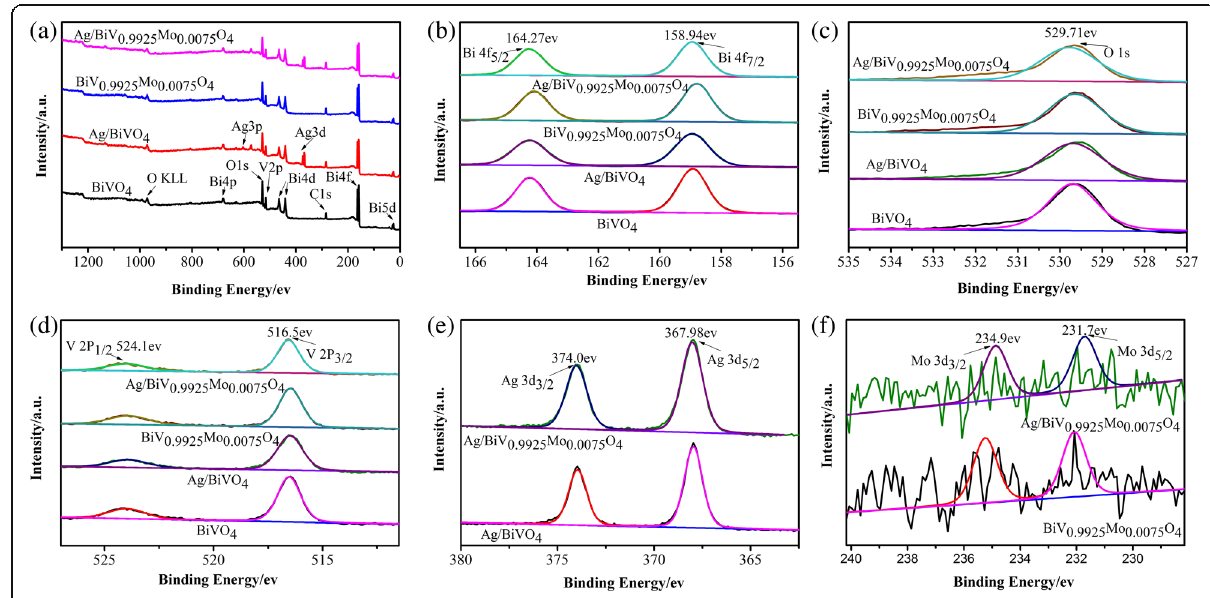
Fig. 5 XPS spectra of the as-prepared photocatalyst. a The survey XPS spectrum, b Bi 4f, c O 1s, d V 2p, e Ag 3d, and f Mo 3d peaks related to the photocatalyst